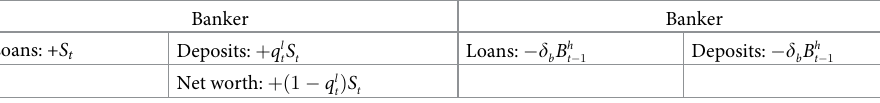
Table 1. Banker issues loans (left) and collects on loans